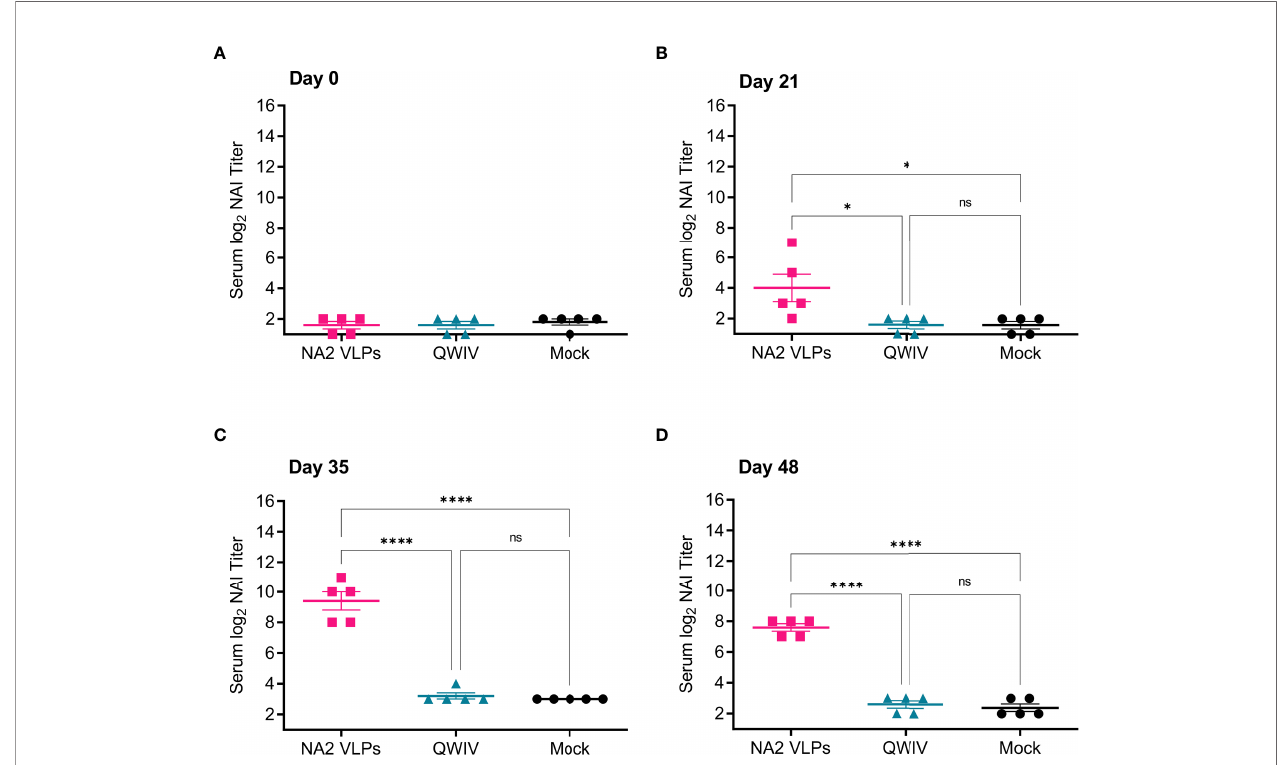
FIGURE 2 | Vaccination with NA2 VLPS induces functional anti-NA antibodies capable of inhibiting A/Perth/16/2009 NA activity in vitro . Three groups of pigs (n=5) were vaccinated in a prime-boost regimen 21 days apart at day 0 and day 21 with a commercial QWIV, NA2 VLPs, or mock vaccinated with water-in-oil-in-water adjuvant only (Mock). Serum was collected on day 0 before prime vaccination, day 21 at boost vaccination, day 35, and at day 48. Neuraminidase inhibition (NAI) titers were de fi ned as the reciprocal of the dilution inhibiting at least 50% of the NA activity of A/Perth/16/2009 in NA2 VLPs. (A) NAI titers at day 0 prior to prime vaccination. (B) NAI titers at day 21 prior to boost vaccination. (C) NAI titers two weeks post-boost vaccination on day 35. (D) NAI titers prior to virus challenge with A/swine/NC/KH1552516/2016 on study day 48. Horizontal bars represent the mean NAI titer for each respective group. Statistical analysis was performed by one- way ANOVA test. * = p < 0.05; **** = p < 0.0001; ns = no statistical